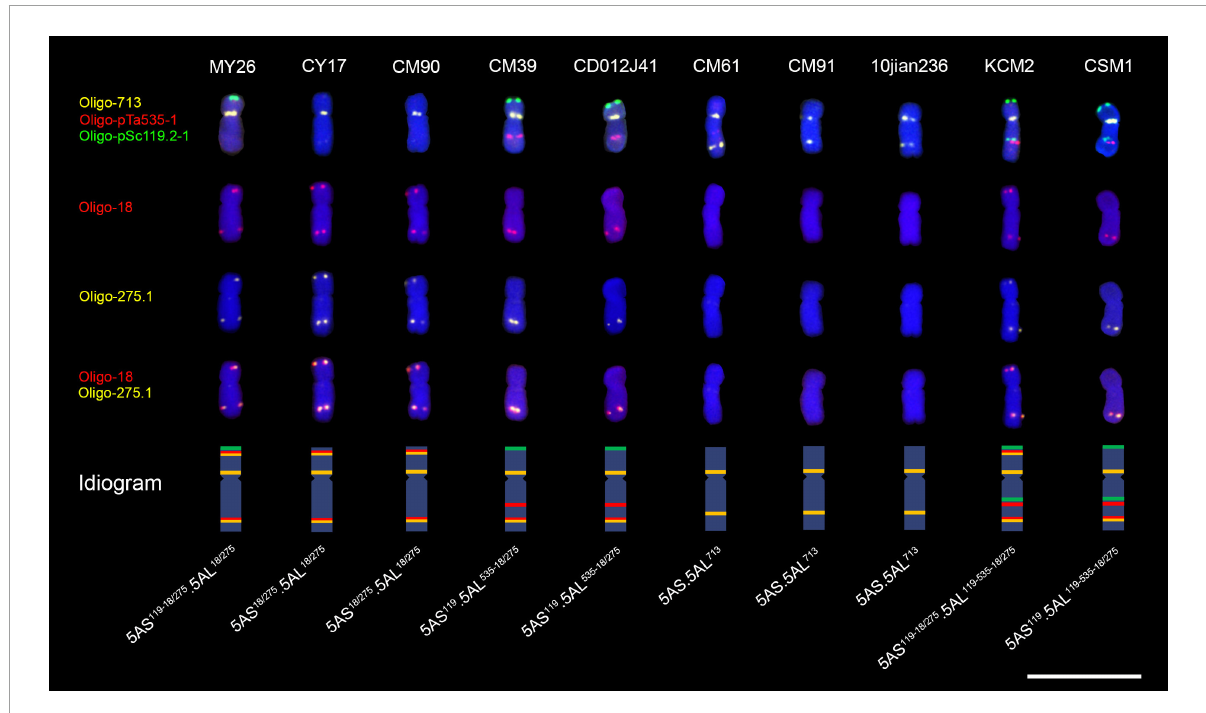
FIGURE1 Signal patterns of five oligo probes on the root-tip metaphase 5A chromosomes of ten wheat cultivars. The ideogram of each chromosome is shown. Scale bar, 20 µ m.